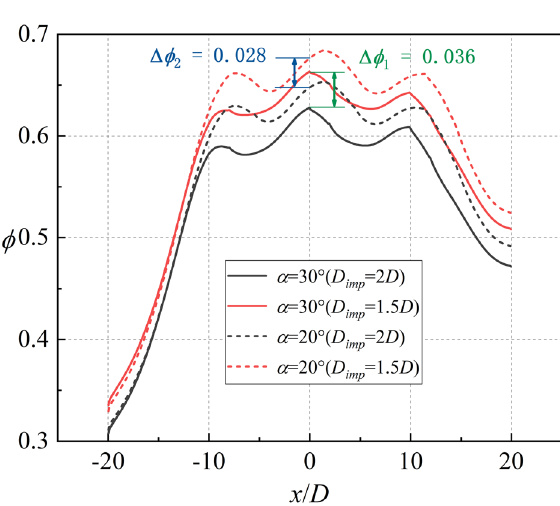
Figure 31. Laterally-averaged ϕ for impingement-effusion